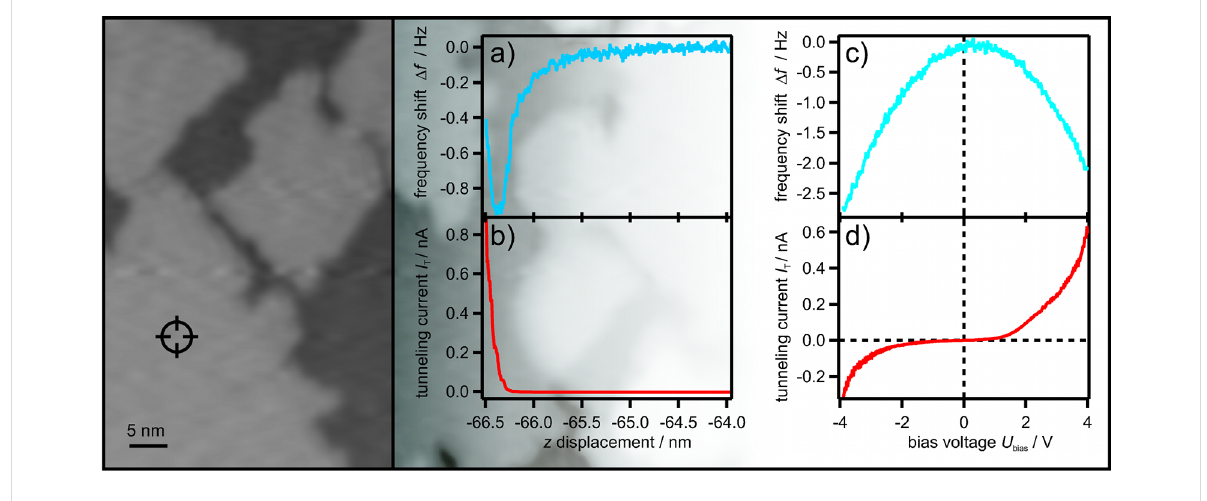
Figure 3: The same tip senses both signals. (a–d) Pairs of simultaneously recorded signal curves from the frequency shift and the current channel: (a,b) signal–distance curves at constant bias voltage, (c,d) signal–bias voltage curves at constant height. On the left-hand side, a STM image of the MgO fi lm recorded with a bias voltage of +3.5 V and a tunneling current of 100 pA is shown. The tip position for the spectroscopy is indicated.